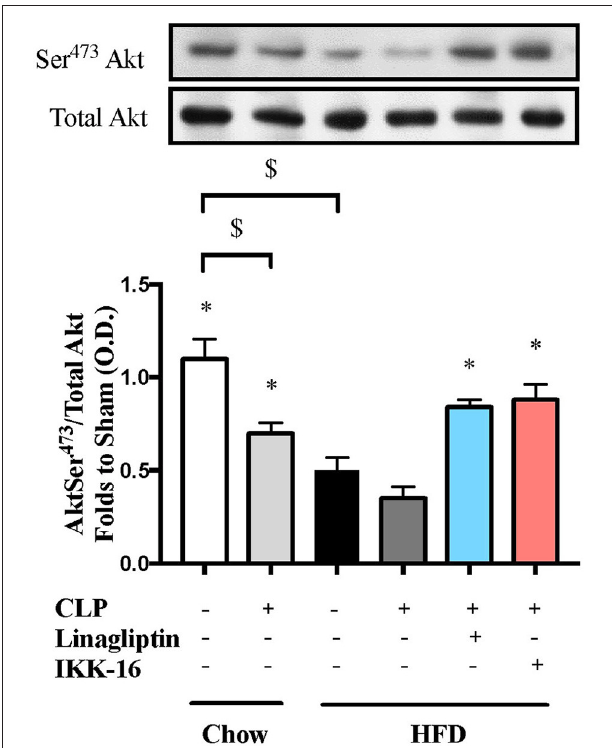
FIGURE 3 | Effects of CLP and linagliptin or IKK-16 post treatment on Akt pro-survival pathway in the heart of mice with pre-existing T2DM. Mice from chow and HFD groups were randomized to undergo CLP or sham surgery. At 1h after CLP, mice on HFD were randomized to receive linagliptin (10 mg/kg i.v.), IKK-16 (1 mg/kg i.v.), or vehicle (2% DMSO, 3 ml/kg). At 24h, heart samples were collected and signaling events were assessed. Densitometry analysis of the bands is expressed as relative optical density (O.D.) of phosphorylated Akt on Ser 473 corrected for the corresponding total